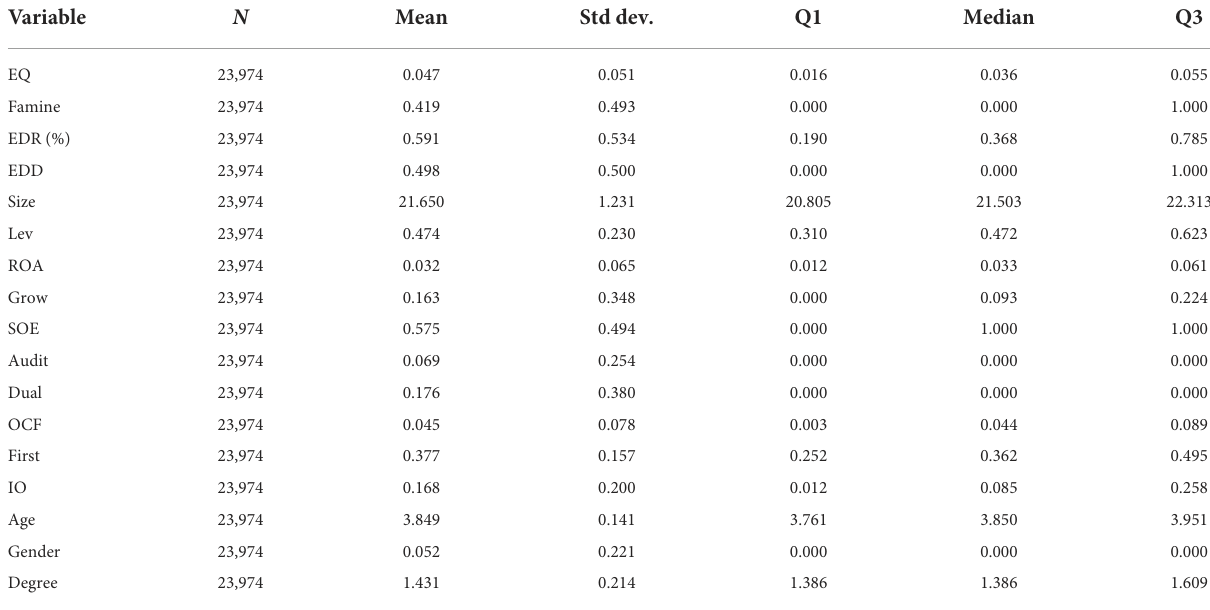
TABLE 1 Descriptive statistics of the main